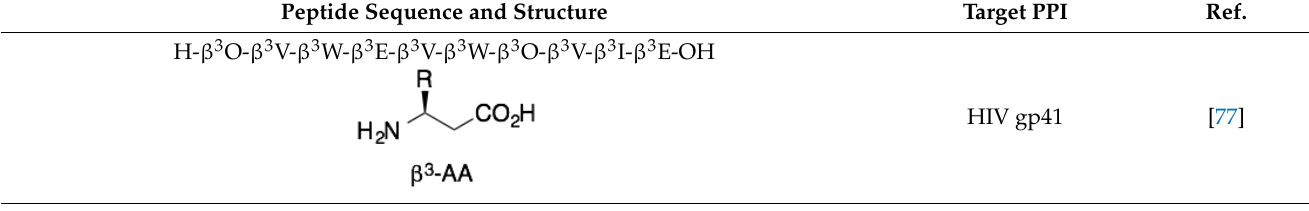
Table 2. β -Peptides as PPI inhibitors. Peptide Sequence and Structure Target PPI